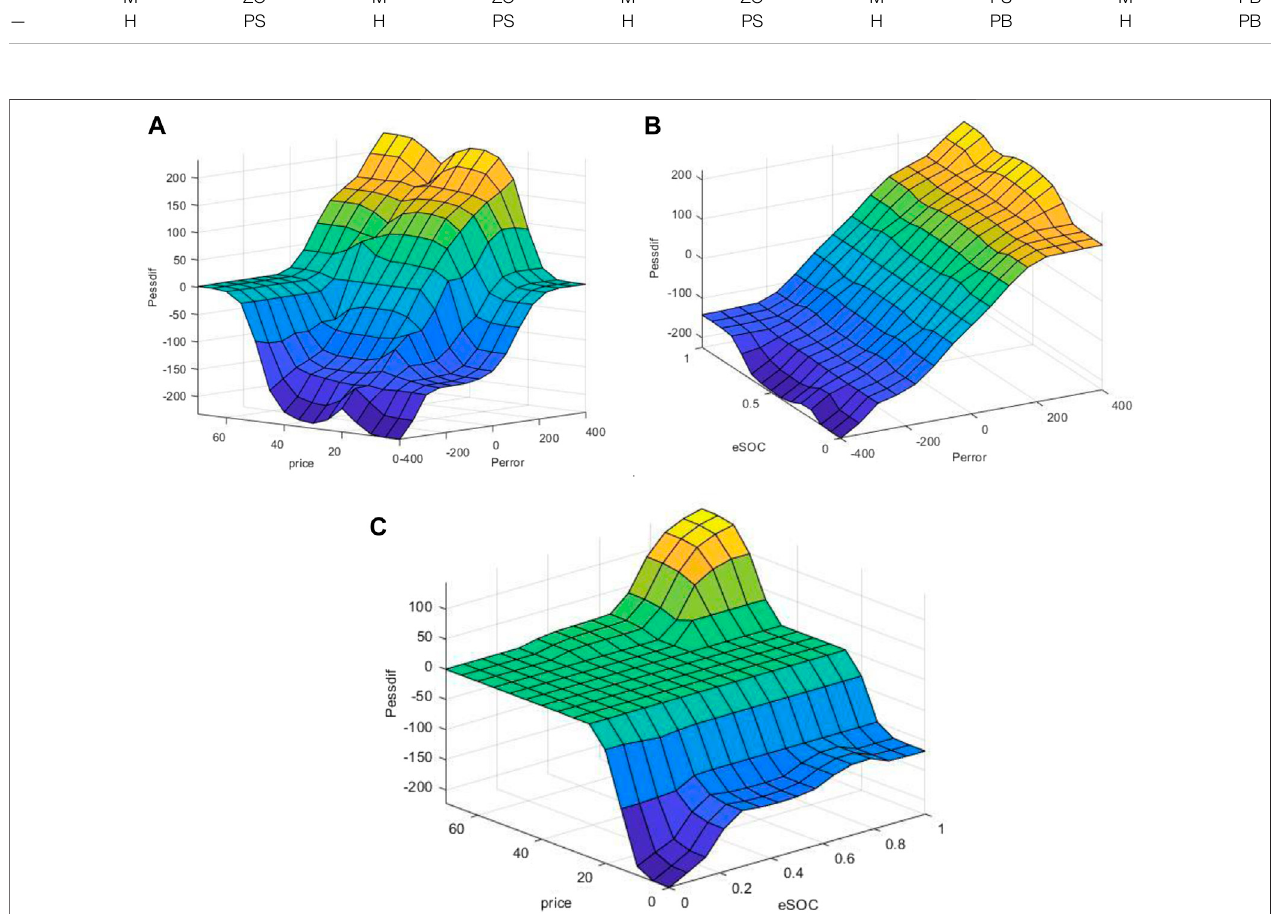
FIGURE 5 | Membership functions of